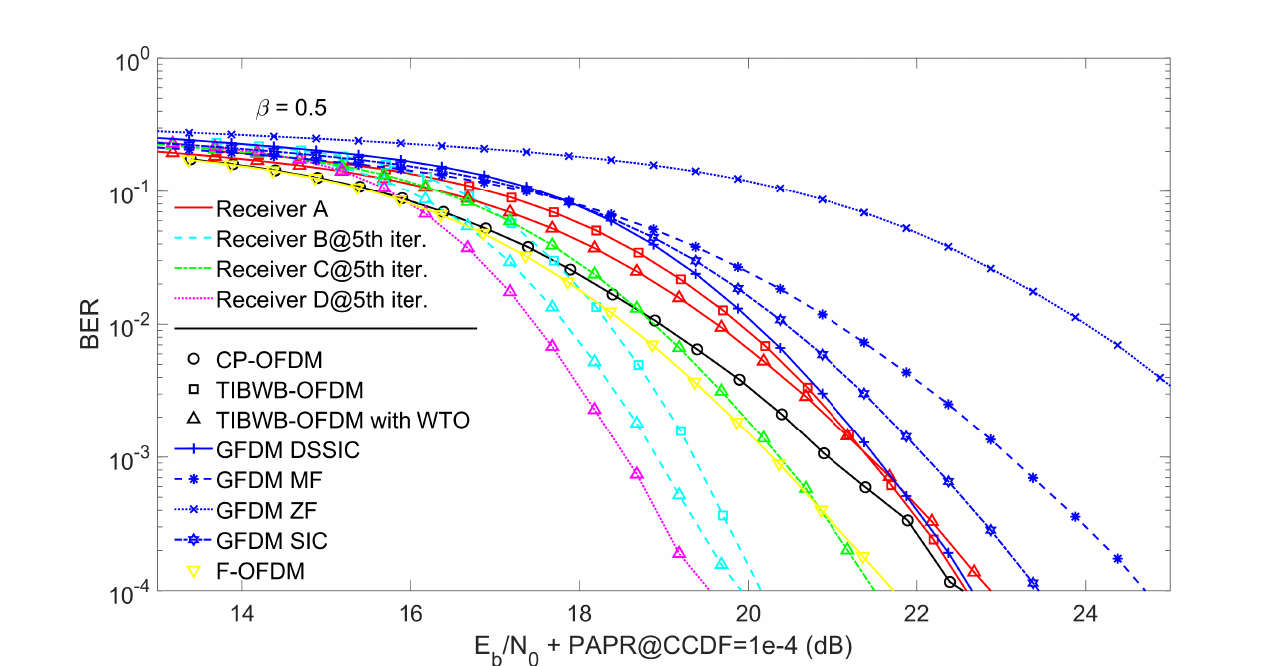
Figure 7. BER performance of 25% CP-OFDM and F-OFDM together with GFDM and TIBWB-OFDM with and without WTO considering the different proposed receivers when β =